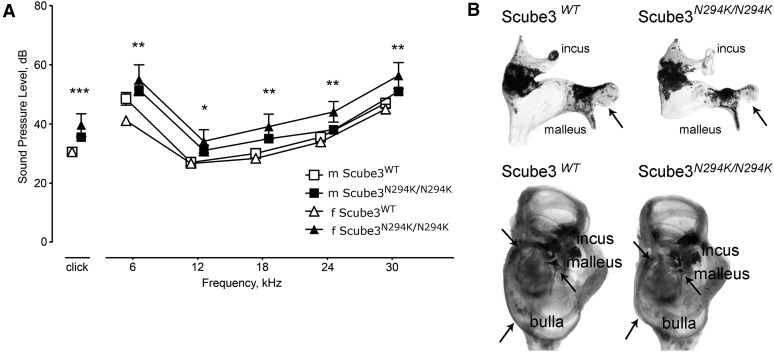
(A) Mild conductive hearing loss; asterisks mark genotype effect of both sexes together. * P < 0.05, ** P < 0.01, *** P < 0.001. (B) Abnormalities in inner ear development. Upper panel: depiction of smaller and malformed ossicles. The ambos (incus) has a different shape and the body of the hammer (malleus) is narrowed (arrow) and the head surface decreased. Lower panel: the whole inner and middle ear was reduced in size and, besides the alterations of the ossicles (arrow pointing toward the hammer, malleus), the auditory cavity (bulla) has an irregular shape (arrows). WT, wild-type.